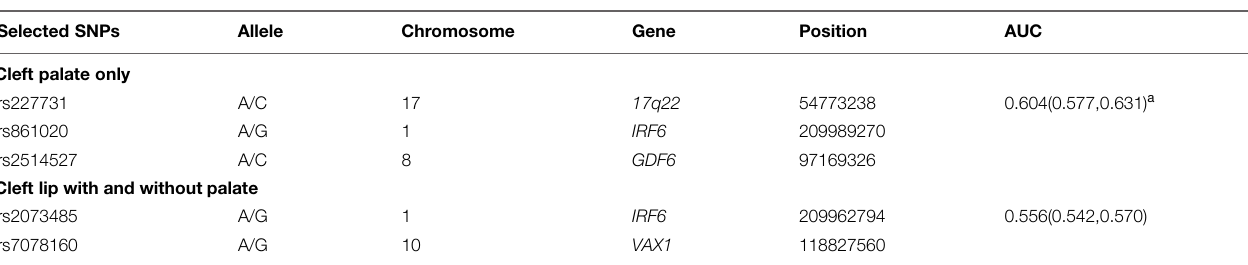
TABLE 3 | Risk prediction models for cleft palate only and cleft lip with and without